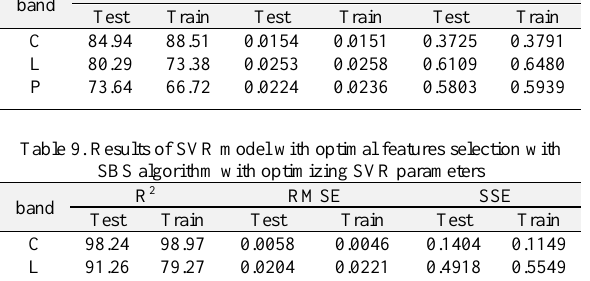
Table 8. Results of SVR model with optimal features selection with SBS algorithm without optimizing SVR parameters